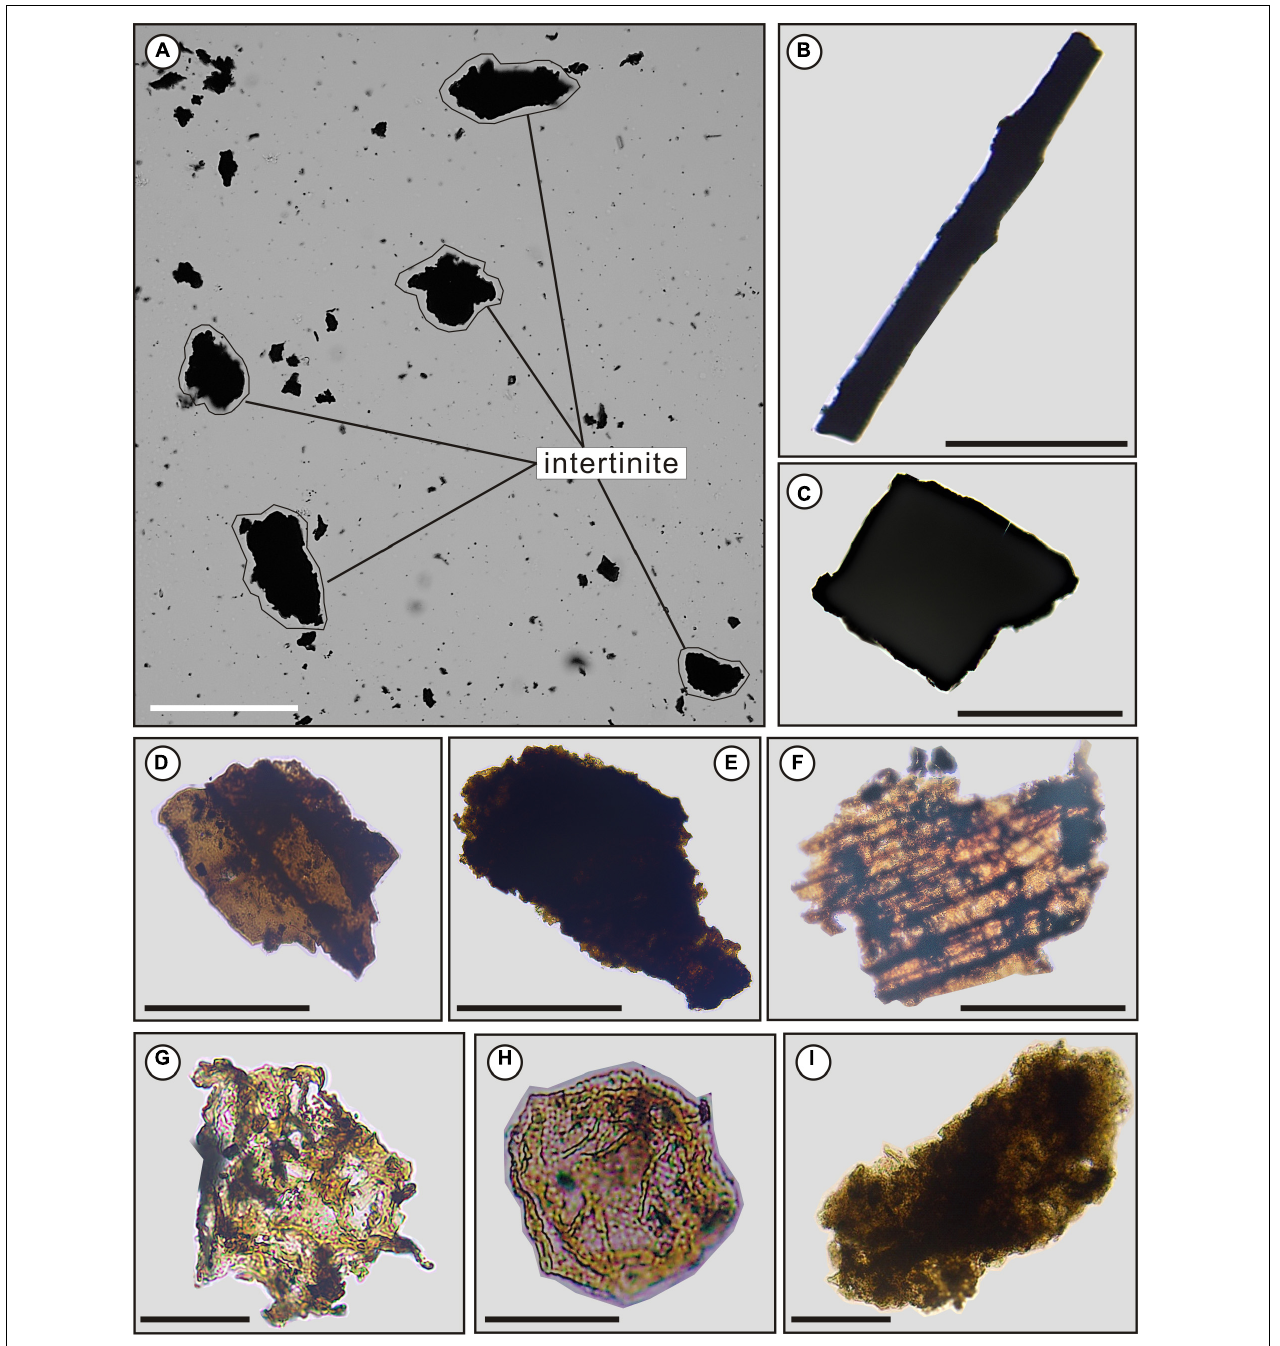
FIGURE 5 | Photomicrographs showing microstructure characteristics of kerogen macerals in the Jiyuan Basin (all scale bars = 50 µ m). (A) Overview showing characteristics of inertinite (transmitted light, sample #38); (B,C) inertinite (transmitted light, samples #39 and #30); (D,E) vitrinite (transmitted light, sample #47); (F) suberinite (transmitted light, sample #19); (G) cutinite (transmitted light, sample #25); (H) saporopollenite (transmitted light, sample #42); (I) sapropelinite (transmitted light, sample